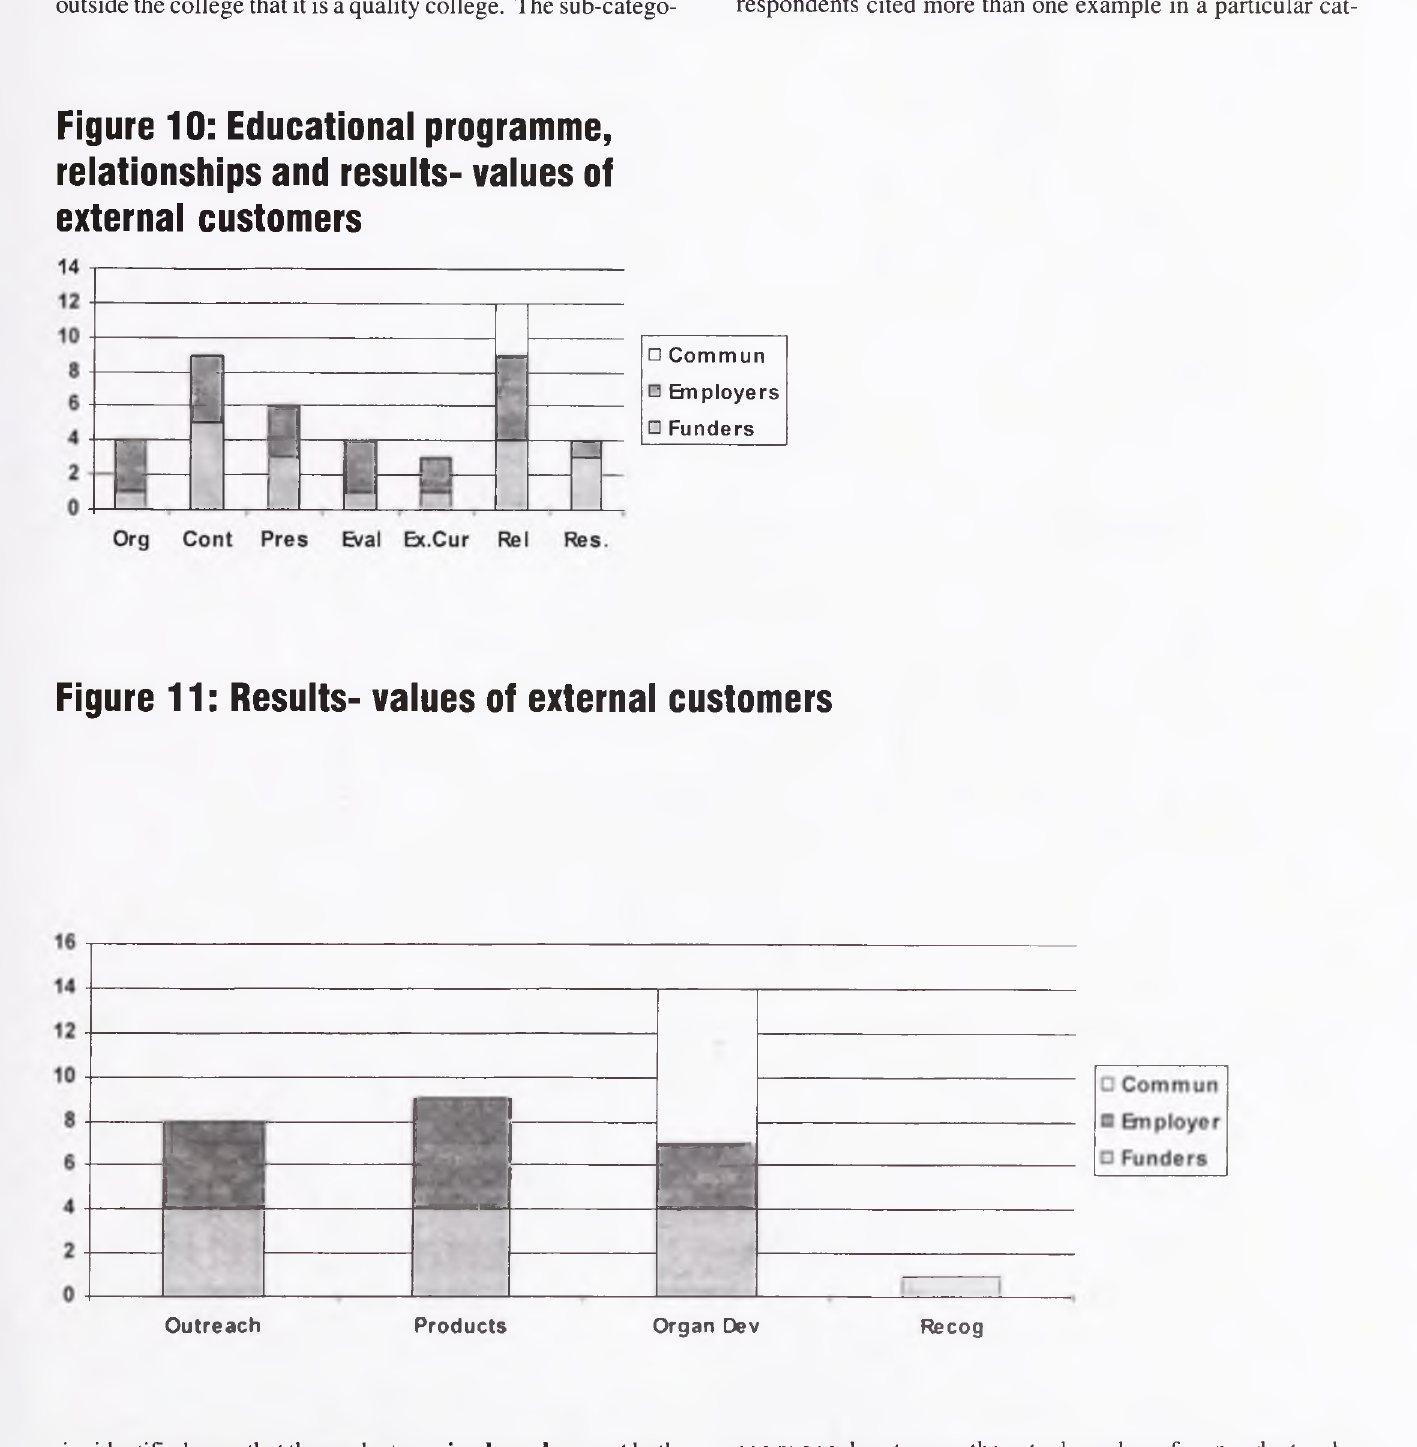
Figure 1 1 : Results- values of external